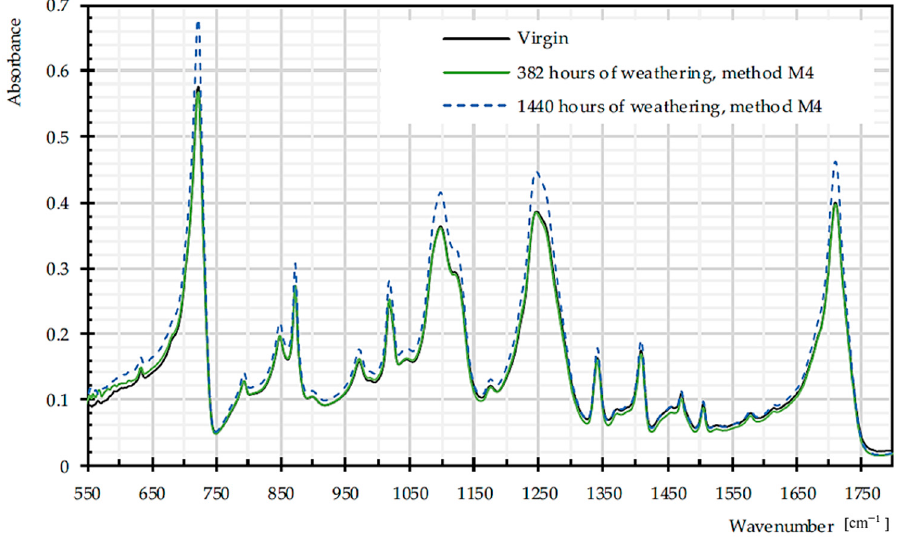
Figure 15. Mean FTIR spectra for virgin and dismantled PET Type II, given from three specimens.